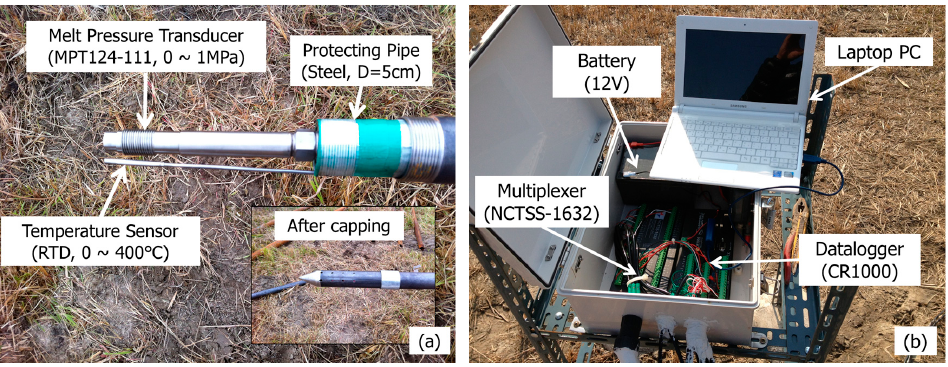
Figure 5. The installation process of the sensors and the measurement systems. ( a ) Installed sensors; ( b ) measurement system.